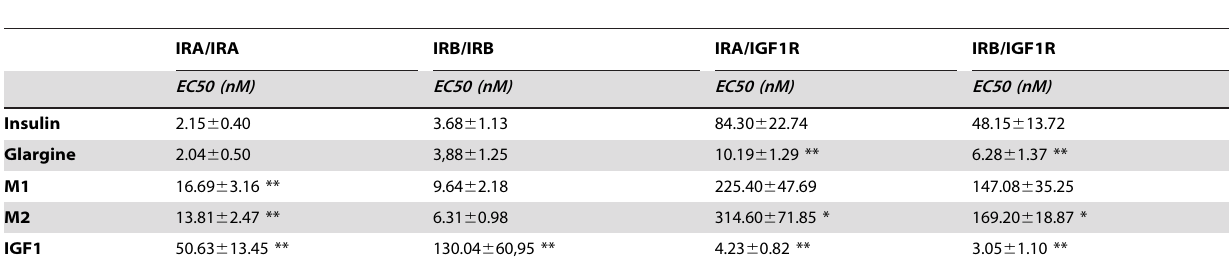
Table 3. EC50s of insulin, IGF1, glargine and glargine metabolites towards IR homodimers and IR/IGF1R hybrids.